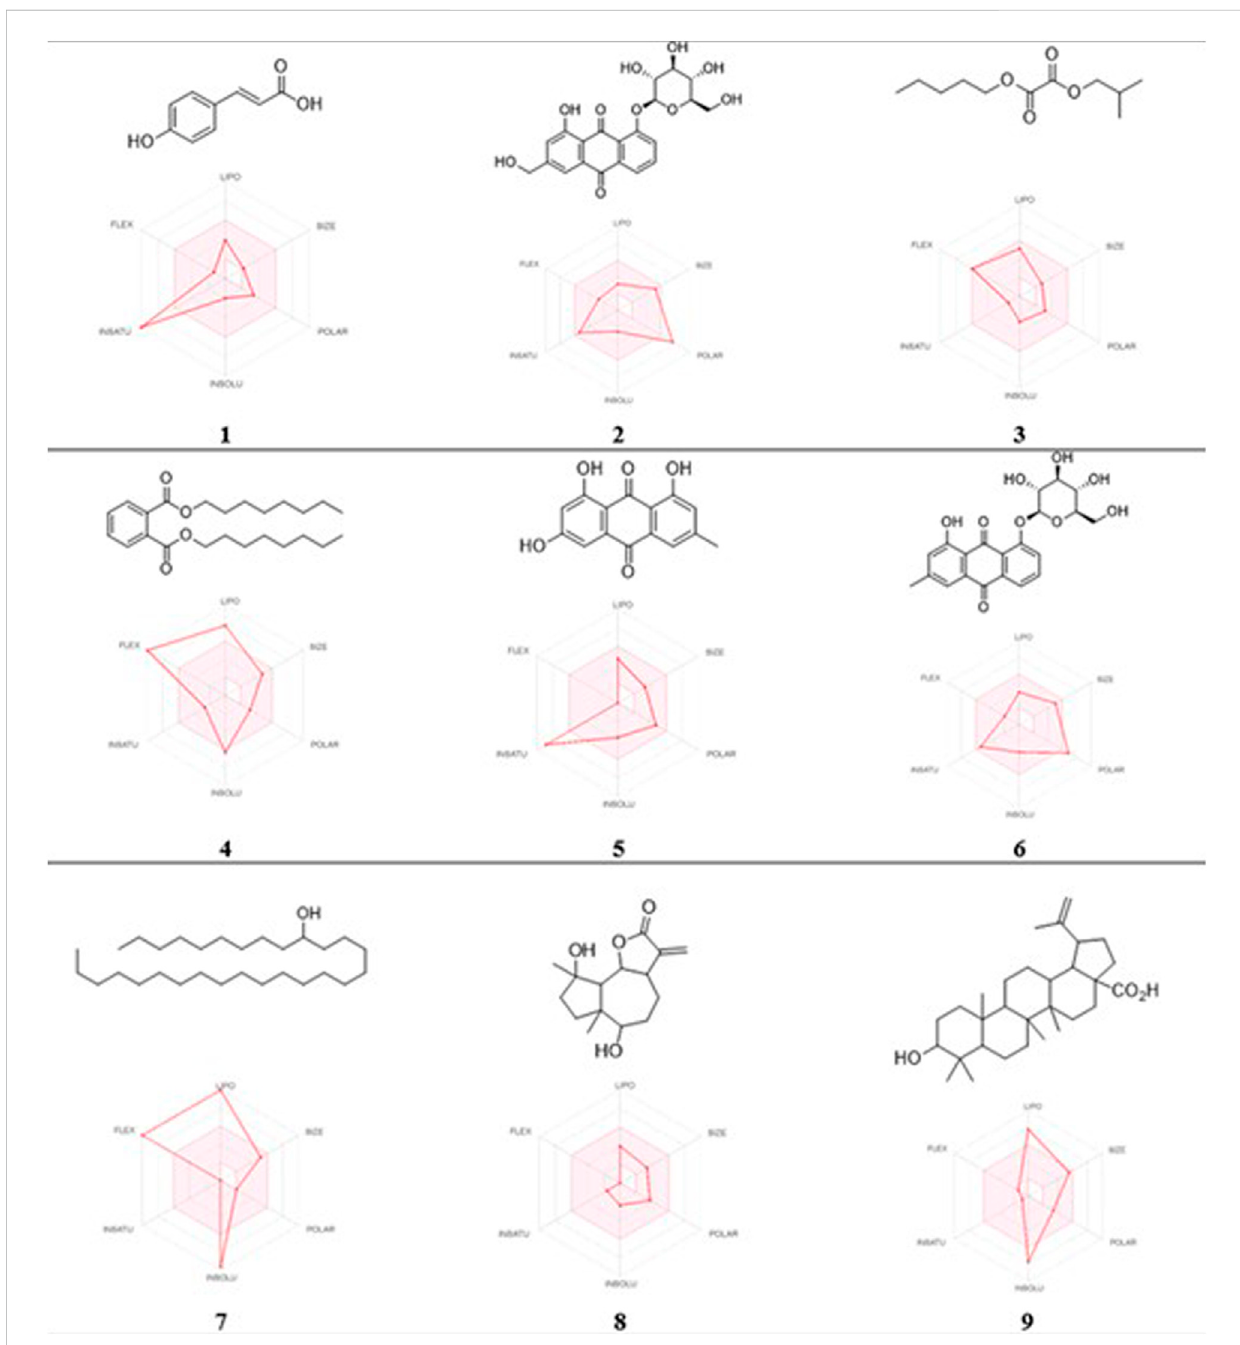
FIGURE 8 2D chemical structures and radar pharmacokinetic representation for the nine identi fi ed metabolites from the L. shawii methanolic extract using SwissADME Webserver. LIPO: lipophilicity, size: molecular weight, POLAR: solubility, INSOLU: insolubility, INSATU: insaturation, and FLEX: fl exibility. The parameters within the colored zone are favored for orally active